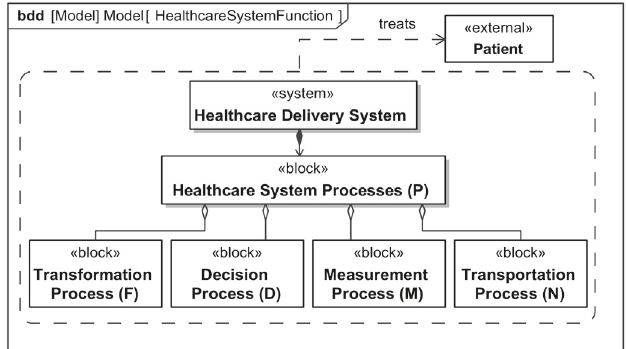
Figure 3: SysML block diagram of healthcare system function.